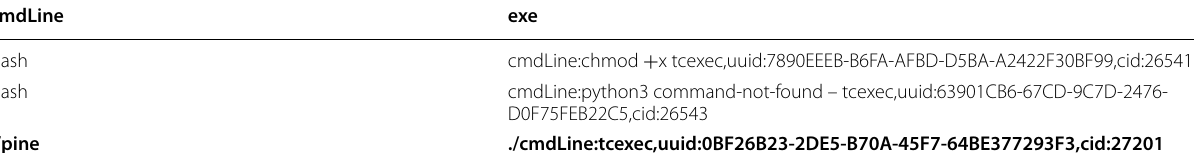
Table 4. shows all the executions caused by the suspi- cious files. Based on expert knowledge and further Table 4 Suspicious execution